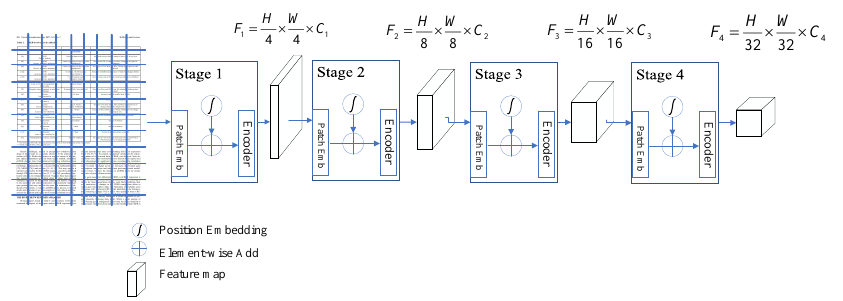
Figure 4. The schema of pyramid vision transformer (PVT). Each stage’s output is passed to the next layer while the first two dimensions are halved (rows and columns). The finished map will be 16 times smaller than the input yet with a greater